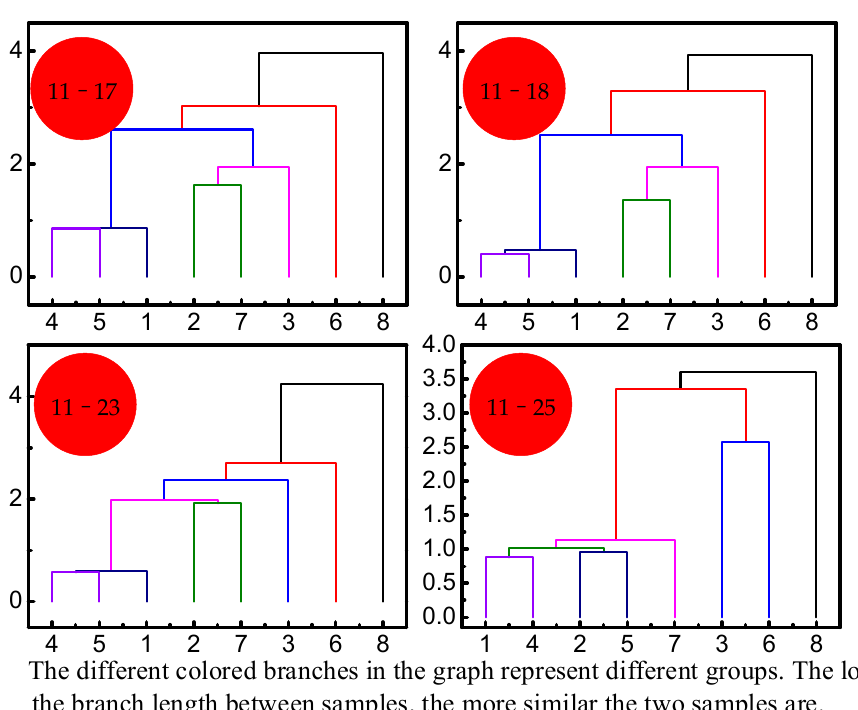
Table 2. Table of cophenetic correlation coefficients for the temperature at different times.